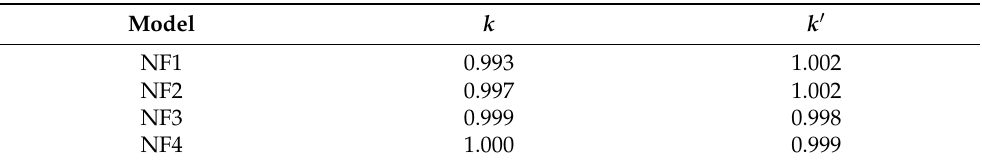
Table 6. The external validation results for the GP